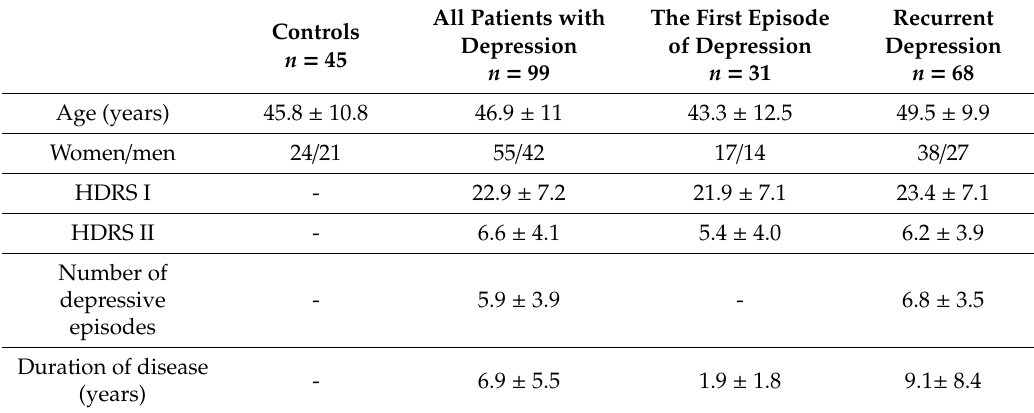
Table 1. Characteristics of the studied group presented as the mean ± SD. HDRS I (Hamilton Depression Rating Scale score on admission); HDRS II (Hamilton Depression Rating Scale score after obtaining clinical improvement).